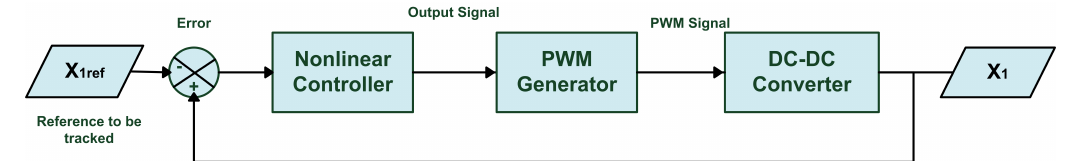
Figure 12. Closed loop system for MPPT control of a PV